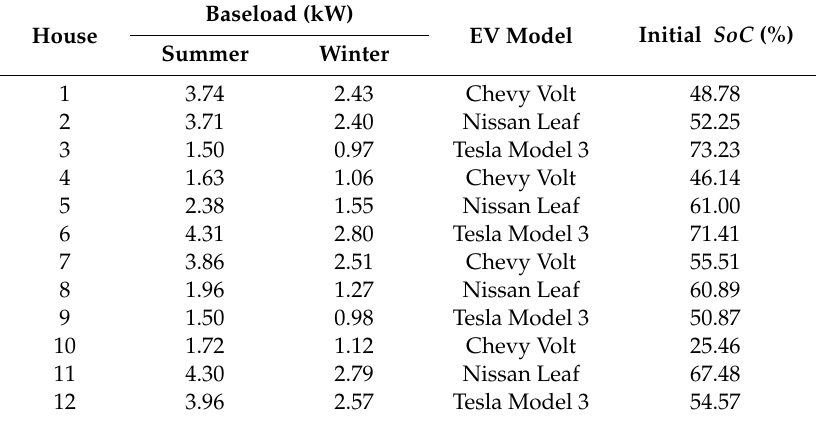
Table 3. Baseload point and EV dataset.